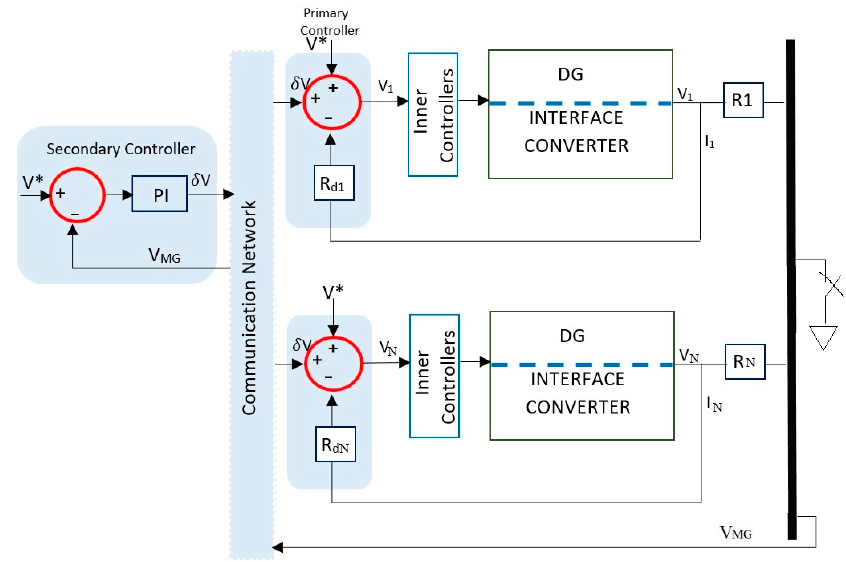
Figure 4. The hierarchical primary-secondary voltage control scheme for a DC microgrid [49].